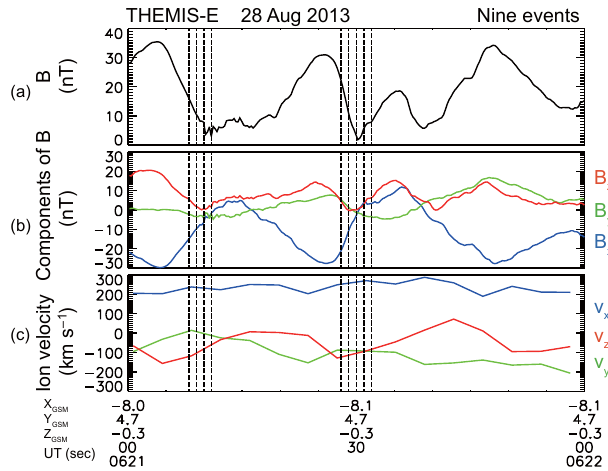
Figure 4. Enlarged plot for example multiple-fluctuation events on 28 August 2013. It shows the 1min time interval after 06:21UT. There were nine severe magnetic fluctuation